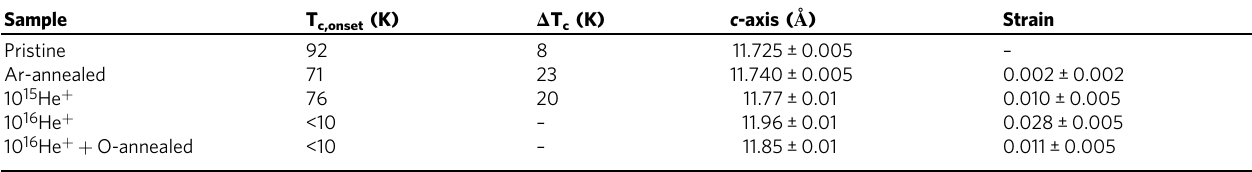
Table 1 Summary of the superconducting and structural properties for the samples used in this study. Sample